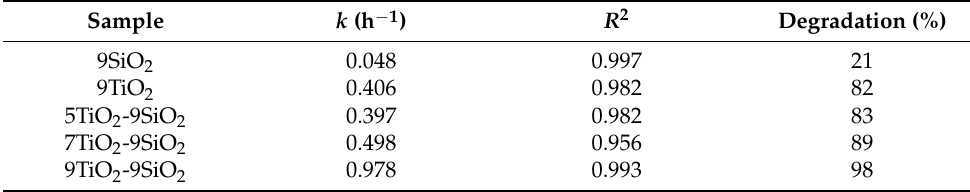
Table 1. Results of the photodegradation of